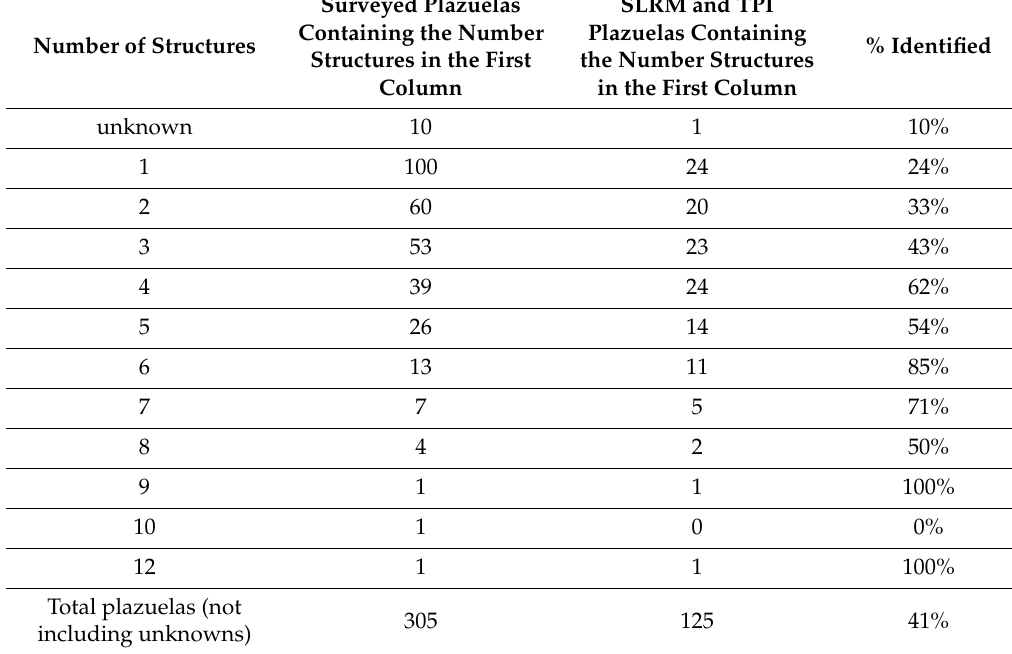
Table 4. Total structure counts of surveyed plazuelas compared to structure counts of plazuelas identified with SLRM and TPI. Plazuelas with more structures are more likely to be remotely identified. Surveyed Plazuelas SLRM and TPI Containing the Number Plazuelas Containing Number of Structures % Structures in the First the Number Structures Column in the First Column